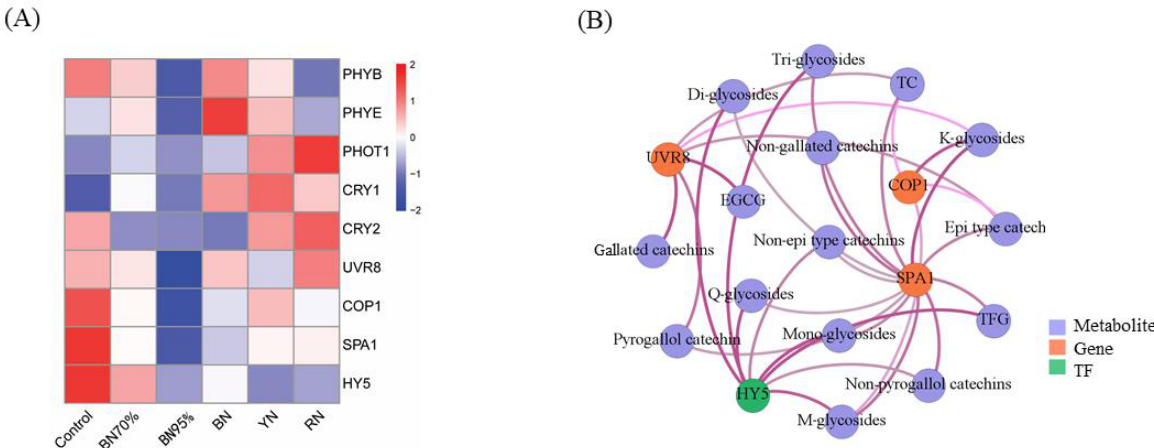
Figure 5. The impact of different shade treatments on the expressions of light signal perception and signaling genes in tea leaves. ( A ) heatmap of the expression levels of light signal perception and signaling genes; ( B ) correlation network of representative genes (orange nodes), TFs (green nodes), and flavonoids (purple nodes). The co-expression network of the FPKM values of light signal perception and signaling genes ( PHYB , PHYE , PHOT1 , CRY1 , CRY2 , UVR8 , COP1 , SPA1 , and HY5 ) and the flavonoid contents (TFG, M-glycosides, K-glycosides, Q-glycosides, Mono-glycosides, Di-glycosides, Tri-glycosides, TC, EGCG, epi type catechins, non-epi type catechins, pyrogallol catechins, non-pyrogallol catechins, gallated catechins, and non-gallated catechins) was conducted by the Cytoscape software (version 3.8.0). Significant correlation was presented based on the statistical test with a robust cutoff ( p -value < 0.05). The correlation coefficient increased from 0.8 to 0.99 as the line color deepened. PHYs: phytochromes; CRYs: cryptochromes; UVR8: UV Resistance Locus 8; COP1: Constitutive Photomorphogenesis 1; SPA1: Suppressor of PHYA; HY5: Long Hypocotyl 5; TC: total catechins; TFG: total flavonol glycosides. Each cell represents the mean value of n = 3 replicates.